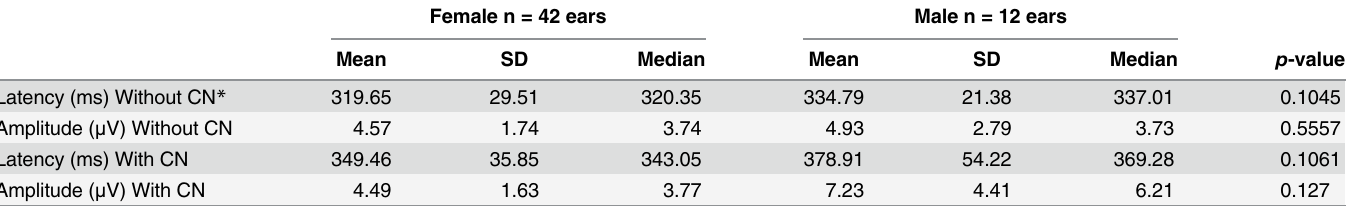
Table 2. Comparison between female and male results regarding to P300 latency (ms) and amplitude ( μ V) measures in both assessment condi- tions: with and without contralateral noise (CN) stimulation.